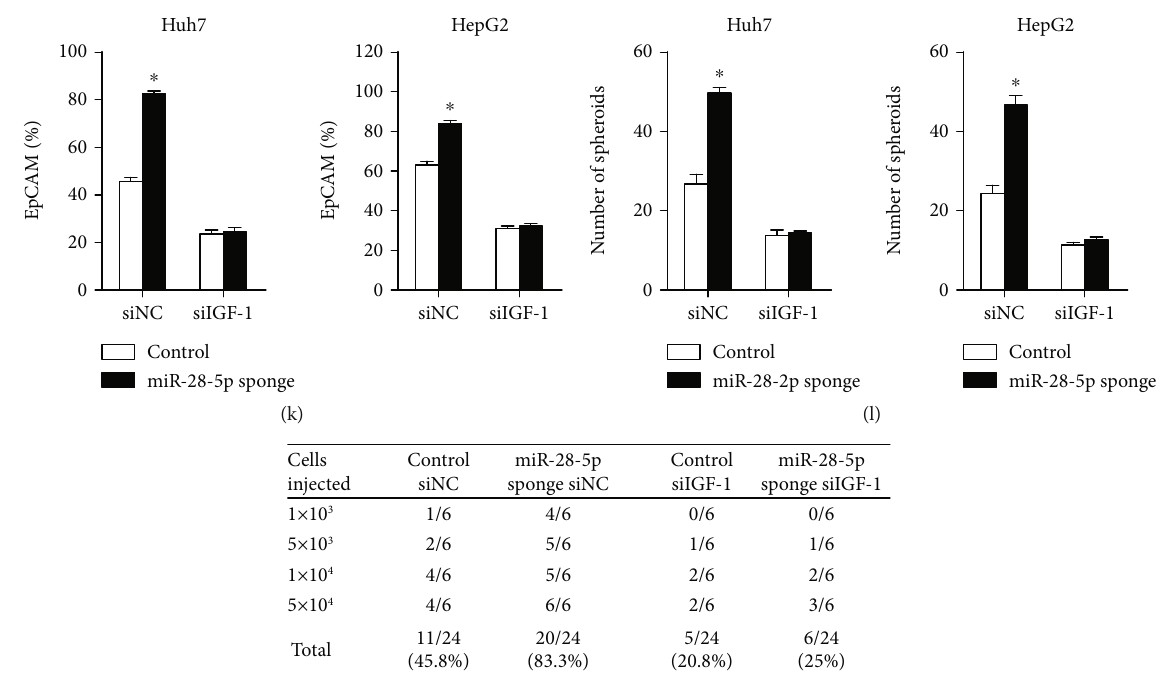
Figure 4: IGF-1 is required for miR-28-5p-mediated liver CSC expansion. (a) The mRNA expression of IGF-1 and IL-34 in the miR-28-5p sponge and control liver CSCs was determined by RT-PCR assay ( n = 3 ). (b) The mRNA expression of IGF-1 and IL-34 in the miR-28-5p mimic and control liver CSCs was determined by RT-PCR assay ( n = 3 ). (c) The protein expression of IGF-1 in the miR-28-5p sponge and control liver CSCs was checked by western blot assay. GAPDH acted as a loading control. (d) The protein expression of IGF-1 in the miR-28-5p mimic and control liver CSCs was checked by western blot assay. GAPDH acted as a loading control. (e) The miR-28-5p potential binding sites at the 3 ′ -UTR of IGF-1 and the nucleotides mutated in the IGF-1-3 ′ -UTR mutant. (f) Luciferase reporter assay was performed to detect the e ff ect of the miR-28-5p sponge on the luciferase intensity controlled by 3 ′ -UTR of IGF-1 ( n = 3 ).(g) The correlation between the transcription level of miR-28-5p and IGF-1 in forty HCC tissues was determined by RT-PCR analysis. Data were normalized to U6 or β -actin as Δ Ct and analyzed by Spearman ’ s correlation analysis. (h) Huh7 and HepG2 cells were transfected with IGF-1 siRNA or negative control and then subjected to western blot assay. GAPDH acted as a loading control. (i) The EpCAM-positive cells in siIGF-1 and control HCC cells were determined by fl ow cytometry ( n = 3 ). (j) The self-renewal ability of siIGF-1 and control HCC cells was compared by spheroid formation assay ( n = 3 ). (k) The miR-28-5p sponge and control HCC cells were transfected with siIGF-1 and siNC followed by fl ow-cytometric assay ( n = 3 ). (l) The miR-28-5p sponge and control HCC cells were transfected with siIGF-1